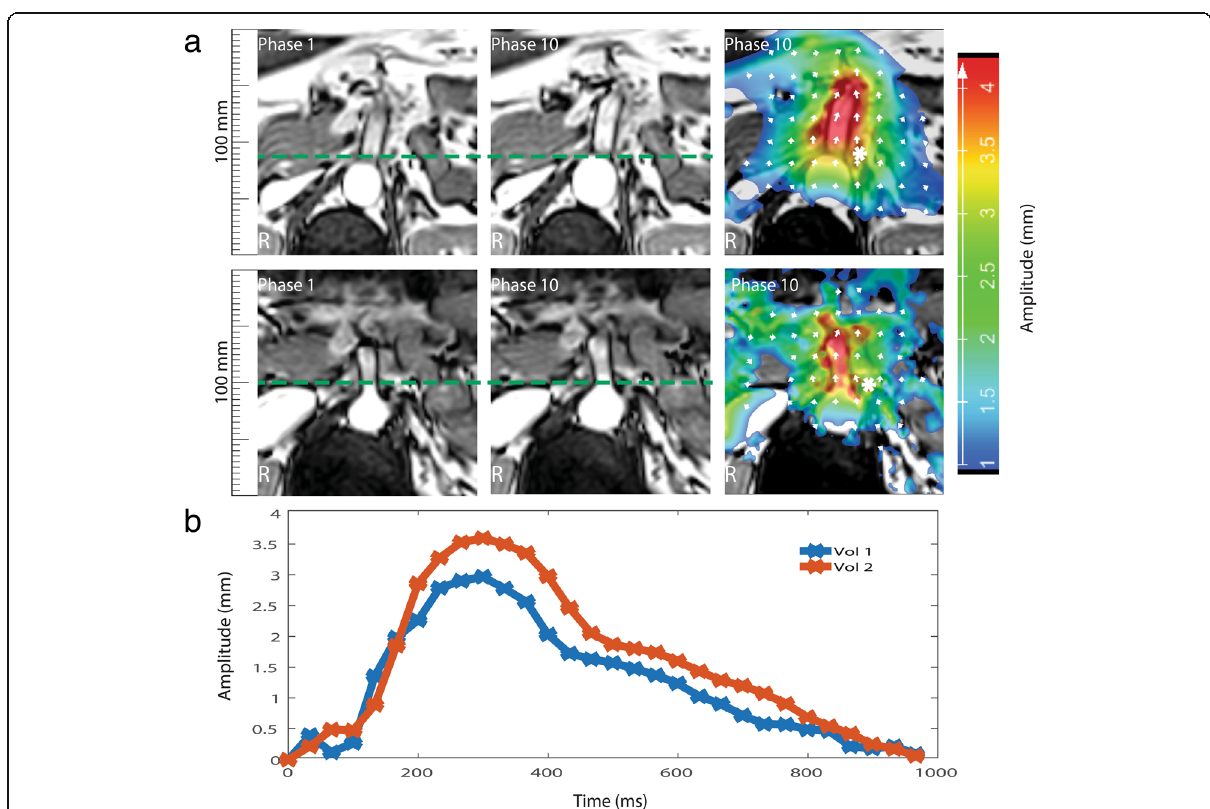
Fig. 1 a Representative cine images acquired in two volunteers at the level of the superior mesenteric artery. Phases with minimum (left) and maximum (middle) aorta diameter are shown, i.e. , phase 1 of 30 and 10 of 30, respectively. The induced displacement amplitude over the cardiac cycle is presented as a colour coded overlay on the anatomy (right). Arrows illustrate amplitude and direction of the displacements. b Variation of the motion amplitude over the cardiac cycle. White asterisks in a indicate where the displacement was